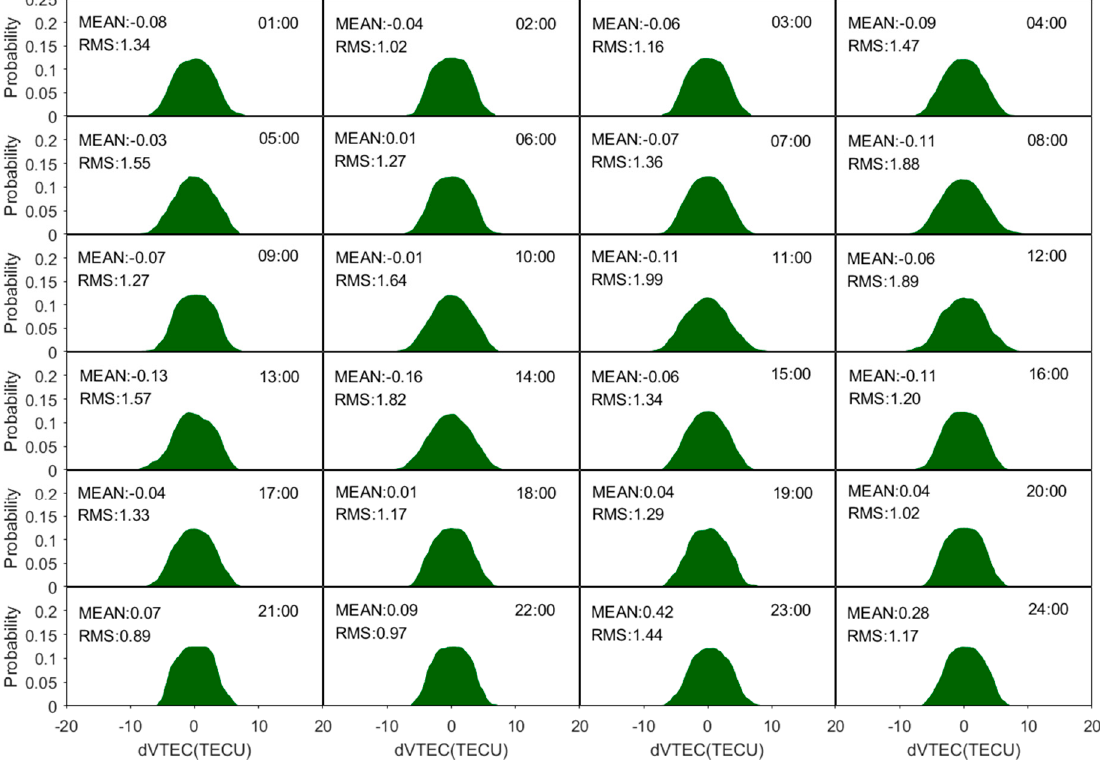
Figure 9. Post-residuals distribution of refinement modeling in DOY 78 of RRTGIM-6.